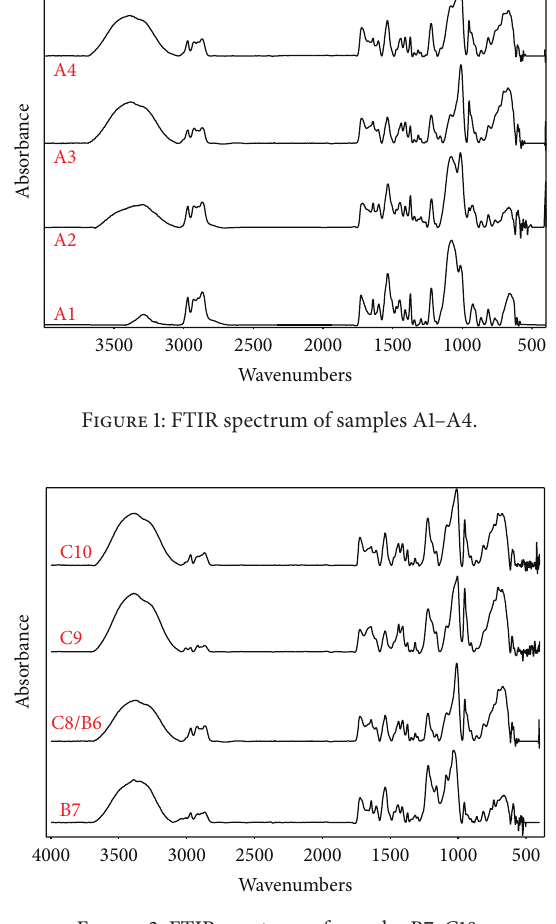
Figure 2: FTIR spectrum of samples B7–C10.